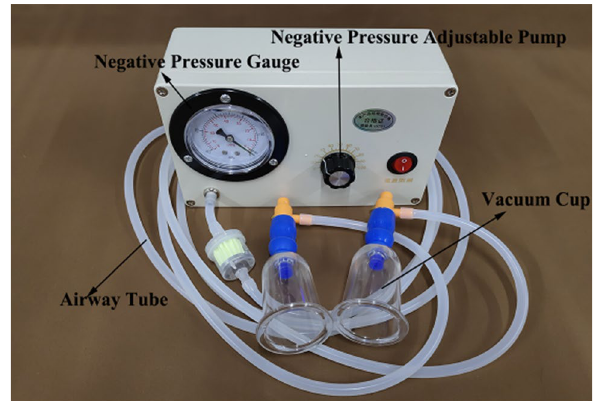
Figure 1. Structure of the electric vacuum-based cupping device.